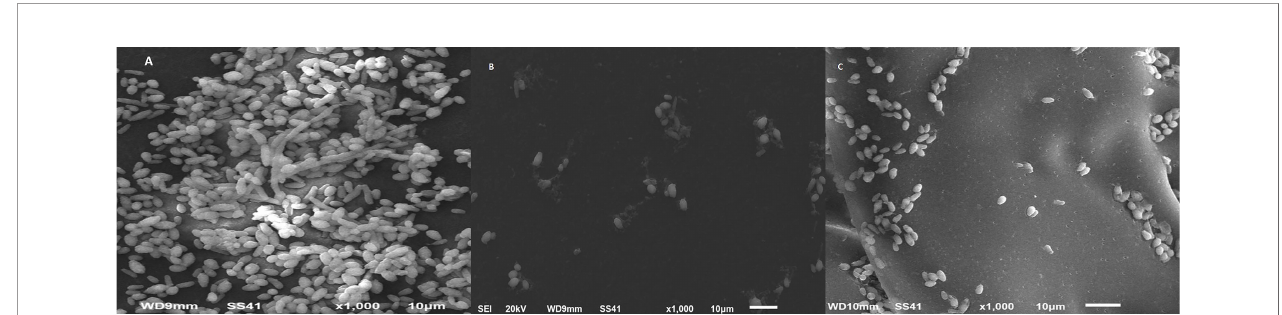
FIGURE 1 | Scanning electron microscopy images of C. albicans bio fi lms. Cinnamon exhibited a profound inhibitory effect on C. albicans bio fi lm formation and preformed bio fi lms. (A) Mature bio fi lm with a multilayer of blastoconidia, pseudohyphae, and extracellular matrix. (B) Bio fi lm formation with cinnamon (1 µg/ml) showing small shrinkage blastoconidia and absence of pseudohyphae. (C) Twenty-four – hour preformed bio fi lm with cinnamon (4 µg/ml) showing a monolayer of small round